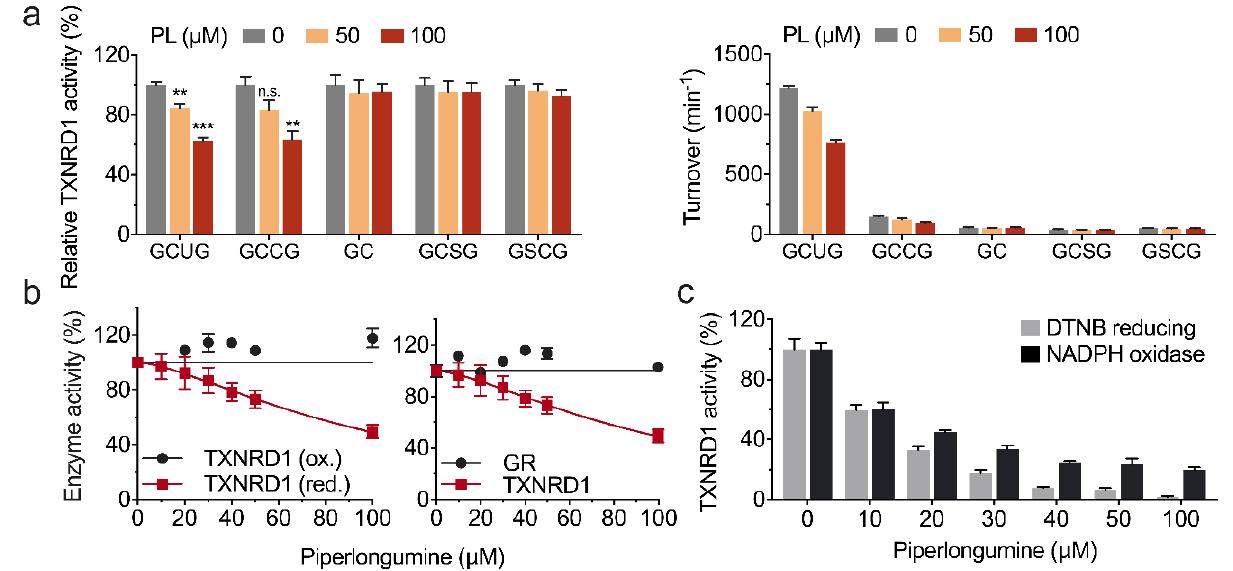
Figure 3. Piperlongumine targets the Sec 498 or Cys 498 residue of TXNRD1 and converts the enzyme to NADPH oxidase. ( a ) Piperlongumine inhibits TXNRD1 and its Sec-to-Cys mutant rather than other Sec-deficiency mutants. NADPH pre-reduced wild-type TXNRD1 (10 nM) and TXNRD1 variant mutants (30 nM for GCCG and 100 nM for other mutants) were incubated with piperlongumine for 30 min, respectively. TXNRD1 activities were determined by using DTNB-reducing assay, and the relative activity was shown in left panel and the absolute turnover was shown in right panel. ( b ) Piperlongumine has no inhibitory effect on oxidized form TXNRD1 and GR activity. 100 µ M NADPH pre-reduced TXNRD1 (red.) or non-pre-reduced TXNRD1 (ox.) or GR was incubated with piperlongumine at various concentrations for 30 min. GR activity was determined using GSSG as substrate in the presence of 200 µ M NADPH. The TXNRD1 activities were determined by using DTNB-reducing assay. ( c ) High concentration of piperlongumine inhibits TXNRD1 Sec-dependent activity but remains NADPH oxidation activity. NADPH oxidation activity was measured by following the NADPH oxidation at OD340 nm using juglone as